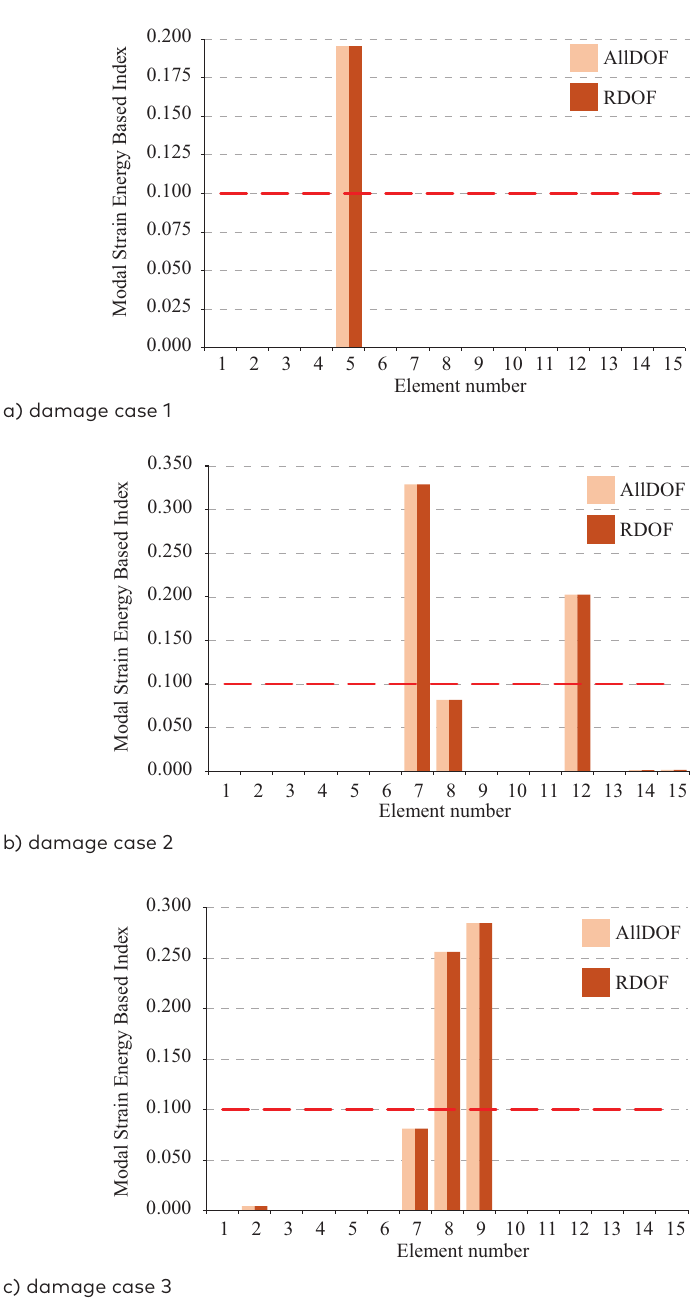
Figure 2. Damage index values in 15-element truss for three modes without